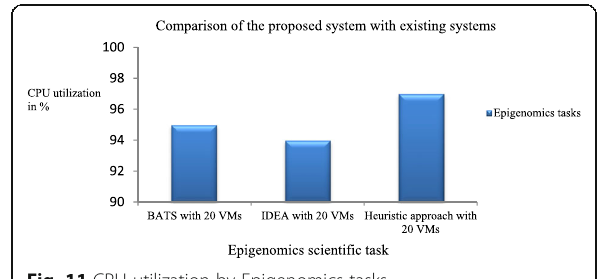
Fig. 11 CPU utilization by Epigenomics tasks